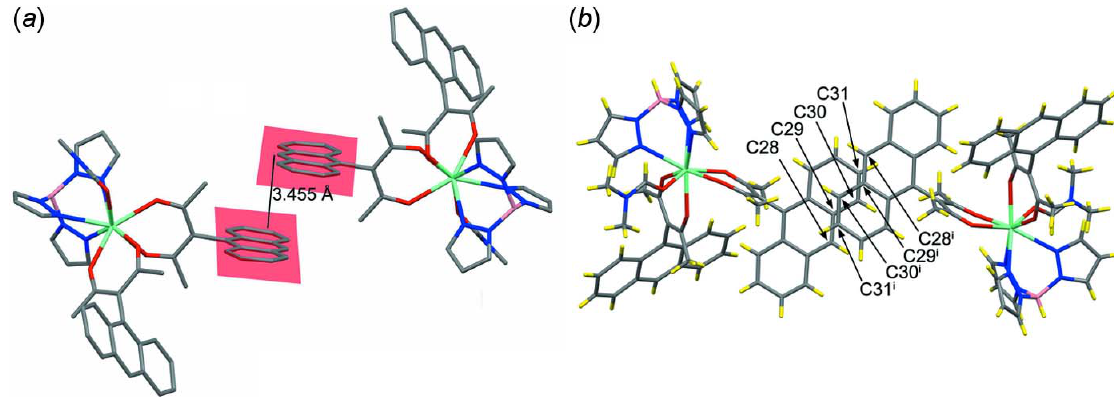
Figure 5 ( a ) View of the (cid:2) – (cid:2) stacking interaction observed for one of the phenylene groups of the anthracene fragments and ( b ) a view of the same, perpendicular to the planes of the anthracenyl (C21—C34) fragments [symmetry code: (i) 2 (cid:2) x , 1 (cid:2) y , 1 (cid:2) z ]. Other occurrences of parallel (but not stacked) anthracenyl units are shown in Figs. S1, S2 and S4.